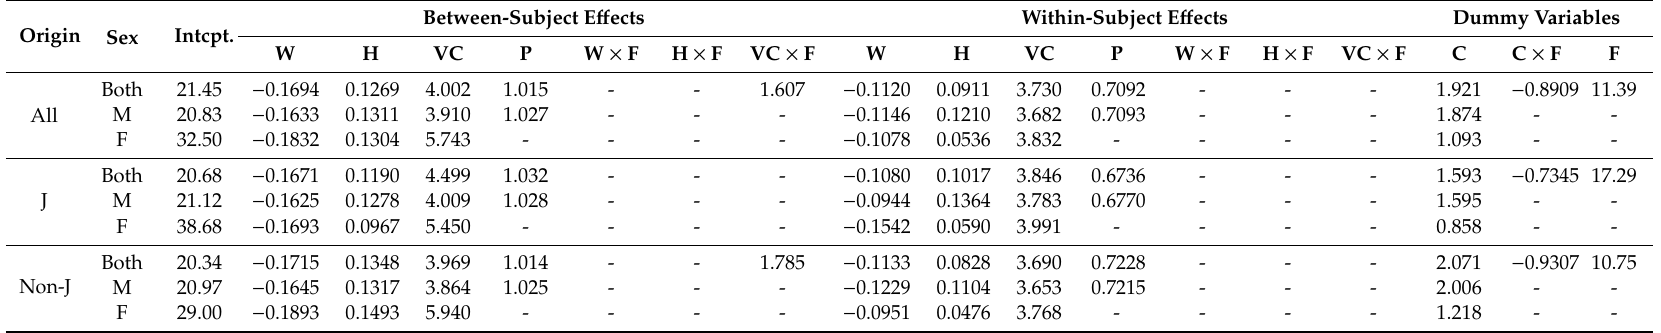
Table 1. Output from the mixed-e ff ects models selected by Bayesian Information Criterion. Estimates of intercept (Intcpt; in points), weight (W; in kilograms), height (H; in centimeters), vital capacity (VC; in liters), pull-ups (P; a count for males (M) only), exposure to mandatory physical education classes (C) of two hours per week, state of being female (F), and their interaction terms in the best mixed-e ff ects models under nine scenarios. 3045 subjects in the regression modeling were comprised of 1039 from the Jiangsu province (J) and 2006 from 30 other provincial regions (Non-J). Gross domestic product (GDP) per capita of home prefectural cities was not in the pool of selected fixed terms under all scenarios. Between-subject e ff ects represent the group-level score point responses to a unit change in the tests, while within-subject e ff ects represent the individual-level score point responses to a unit change in the